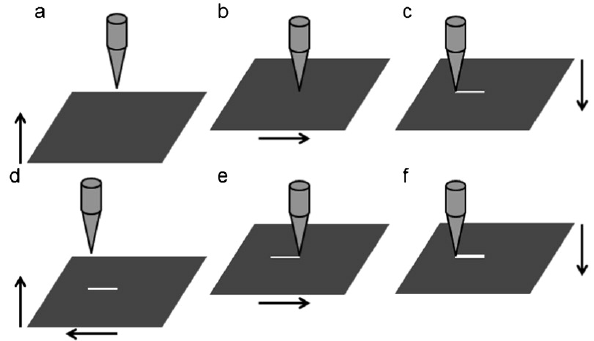
Figure 3: Diagram of constant load, unidirectional multipass scratch